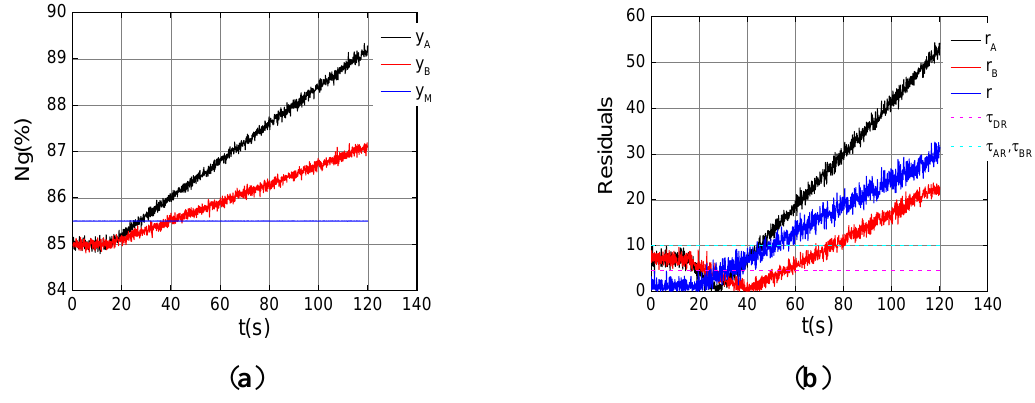
Figure 11. Dual channel fault with the same drift velocities under the steady state of ng % = 85%. ( a ) Triplex channel outputs; ( b ) Drift fault